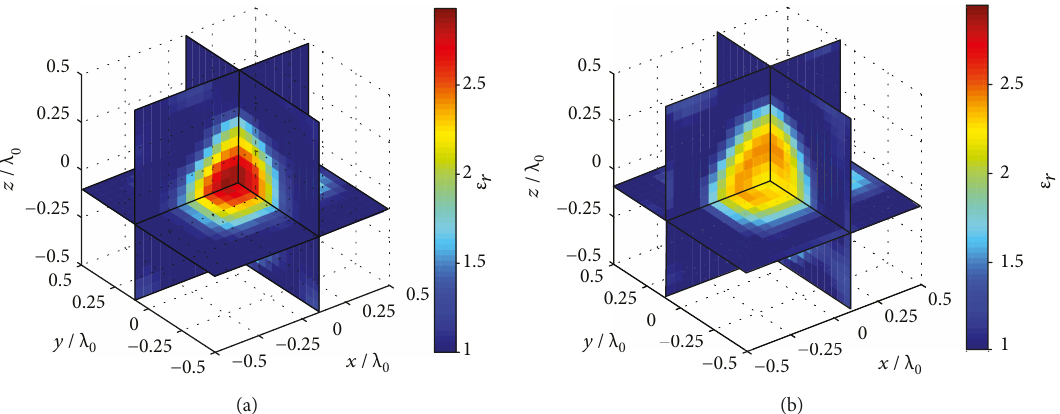
Figure 4: Three-dimensional view of the reconstructed distribution of the dielectric permittivity with (a) p = p dielectric sphere with a